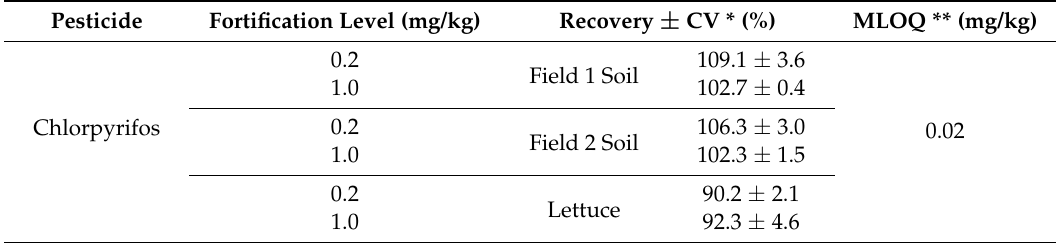
Table 2. Recovery of chlorpyrifos from the tested soil and lettuce.